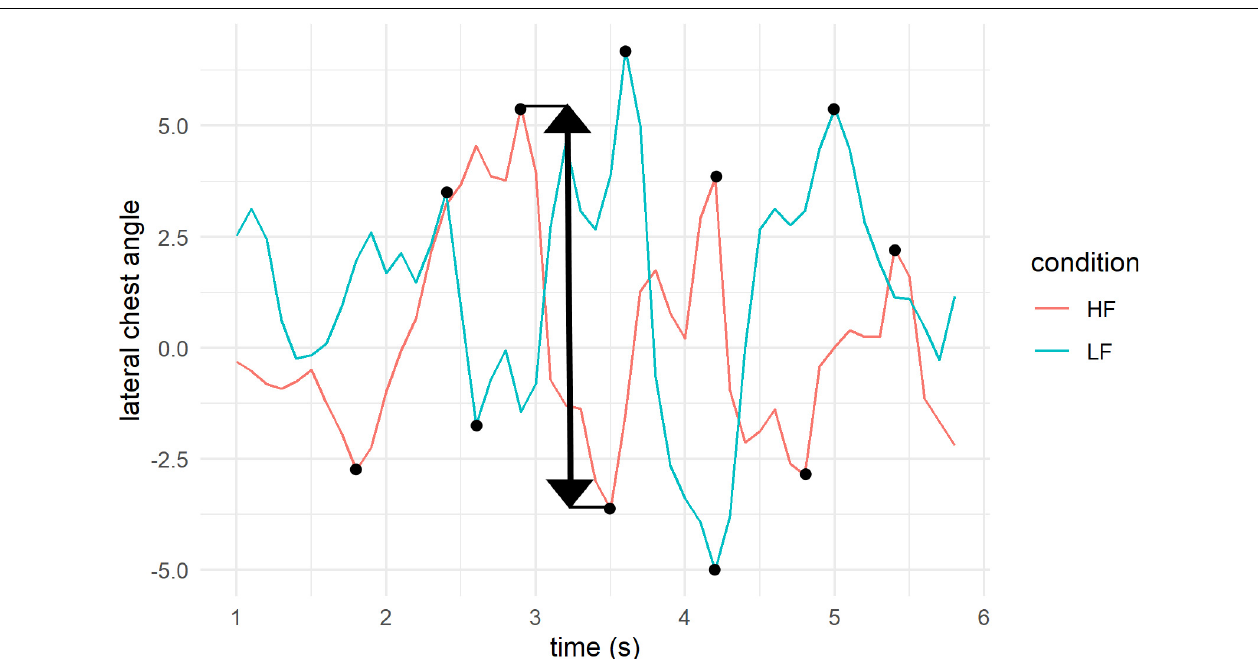
FIGURE 2 | Example plot of lateral chest tilt in high and low frequency. The black dots represent the manually annotated peaks and valleys. We calculated the absolute differences between a consecutive peak and valley (black arrow). Based on these distances, two values were extracted: the average distance (sum divided by the total number of peaks and valleys) and the maximal distance between consecutive peaks and valleys in a walking